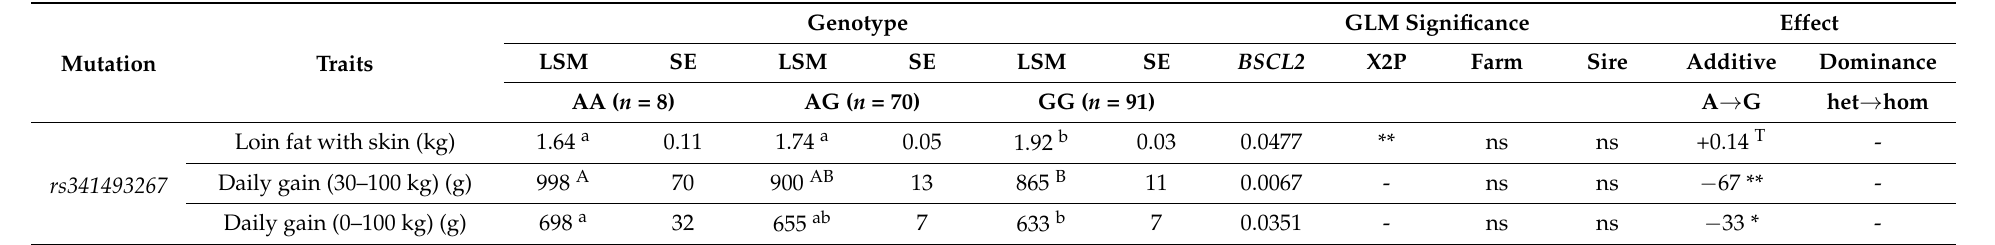
Table 7. Means as least-square means (LSM) with standard error (SE) for pig production traits dependent on BSCL2 genotypes for Polish Large White.